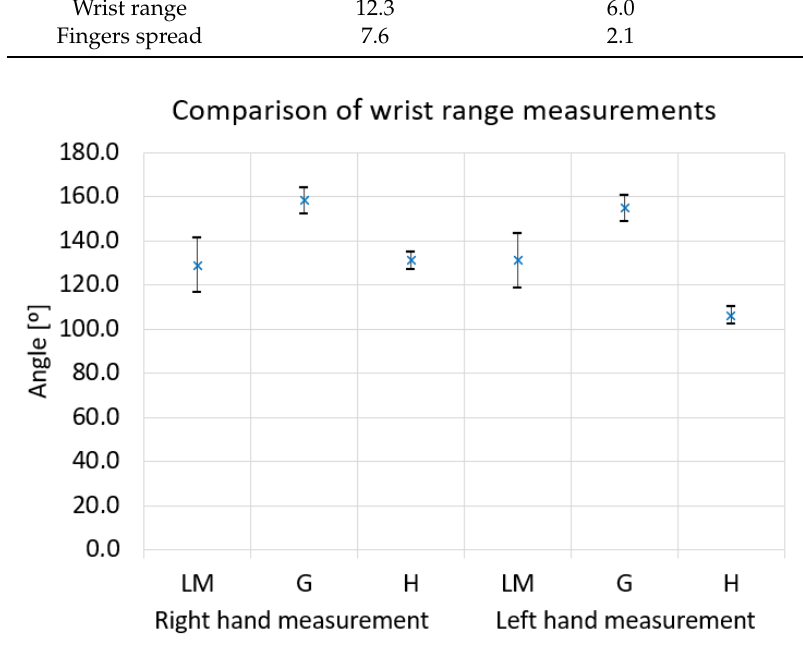
Figure 9. Comparison of angle measurement by Leap Motion (LM) and Goniometer(G) and Haptic device (H) for wrist